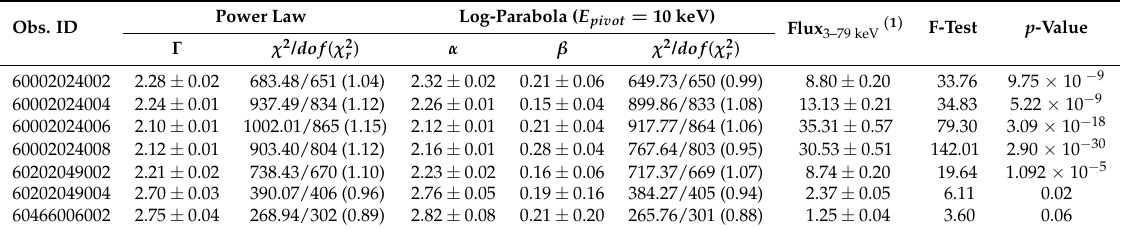
Table 3. Model fits to the NuSTAR spectra of Mrk